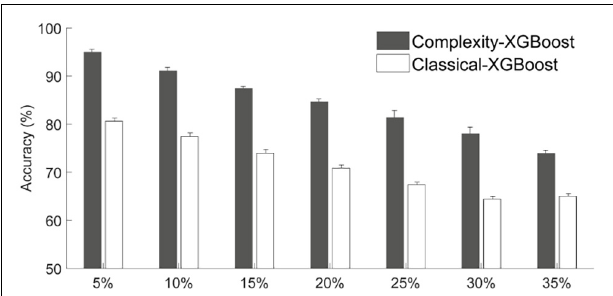
FIGURE 8 | The effects of the significance level α to classification accuracy.